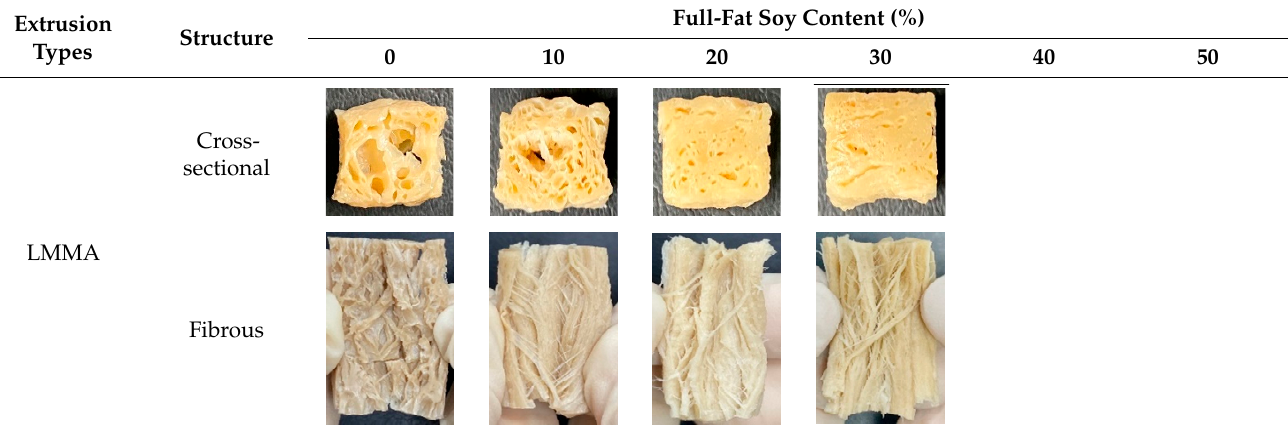
Table 5. Fibrous and cross-sectional structures of extruded high-moisture meat analogs with differ- ent full-fat soy (FFS) content.